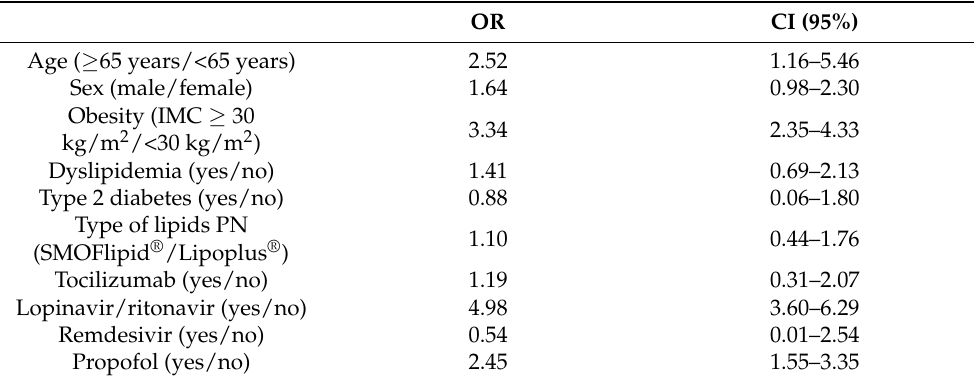
Table 4. Risk factors associated with the development of hypertriglyceridemia (>400 mg/dL) accord- ing to a logistic